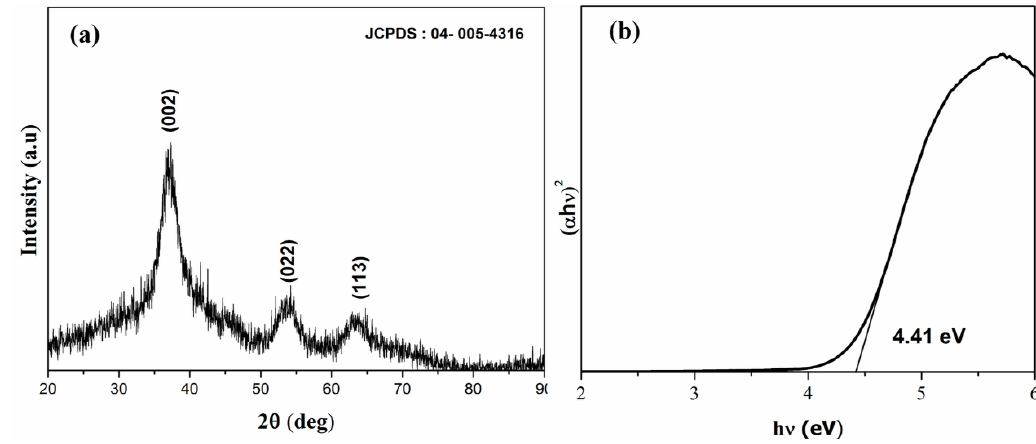
Figure 1. ( a ) X-ray diffractogram and ( b ) Tauc plot of MgO 2 .